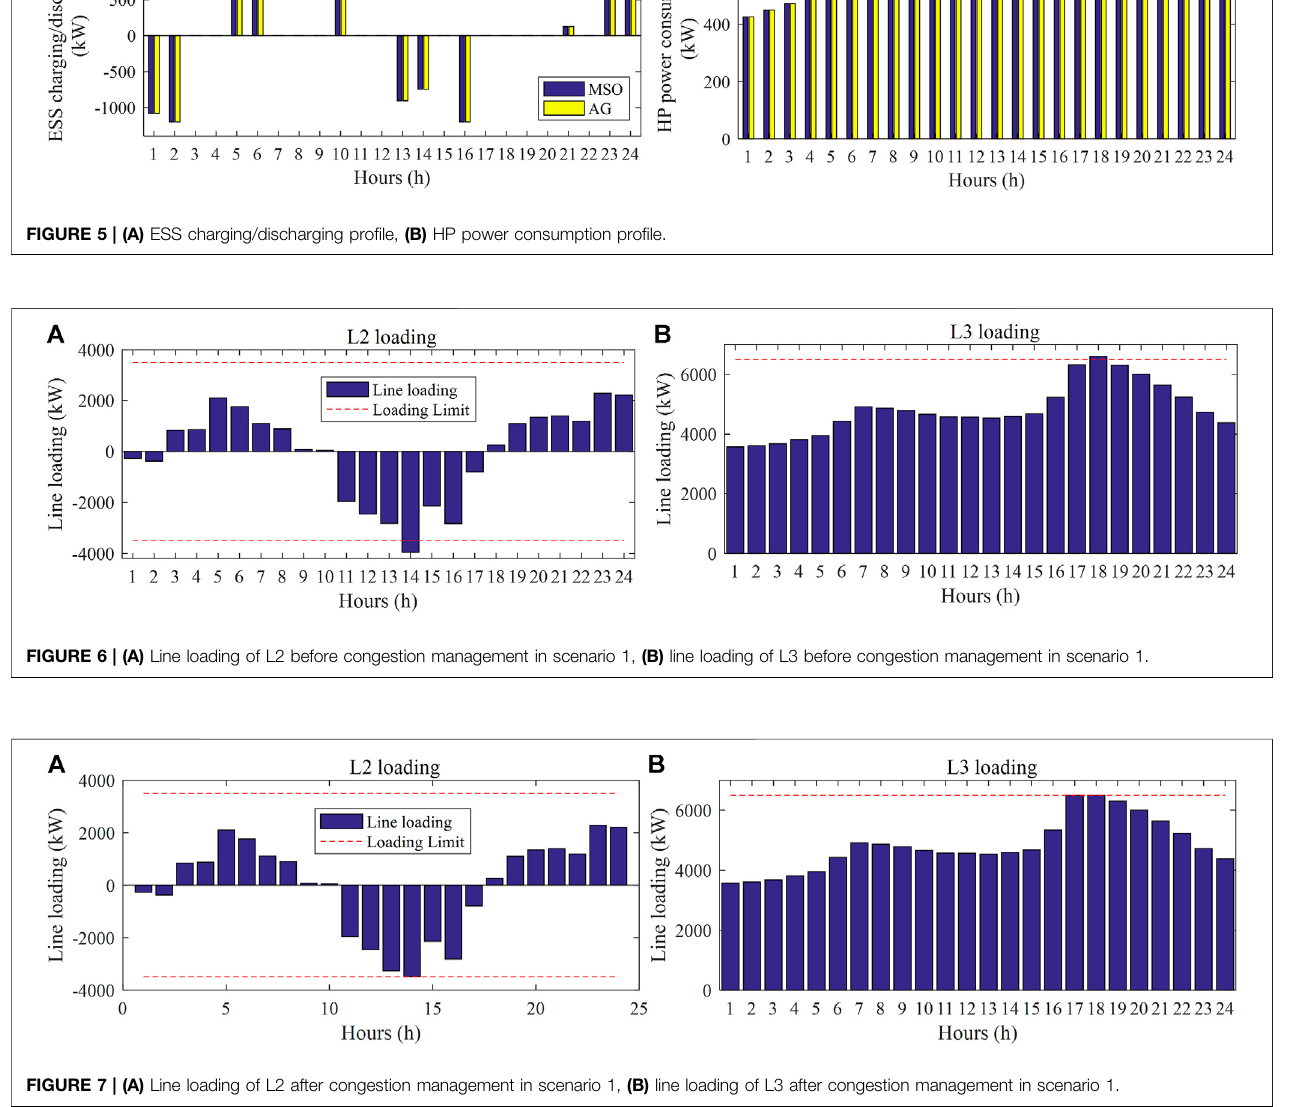
Frontiers in Energy Research |